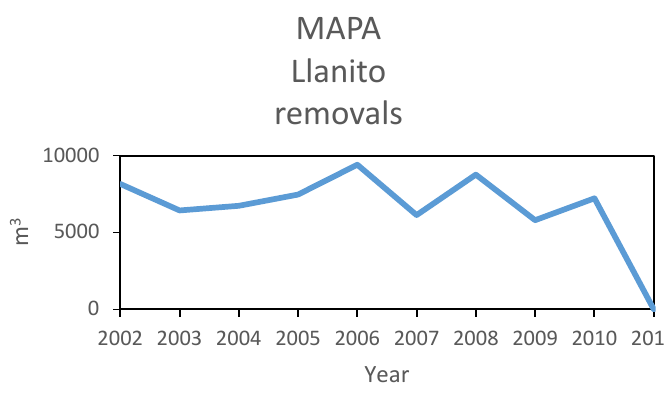
Figure 7. Output volume in El Llanito y cuatro más, managed by